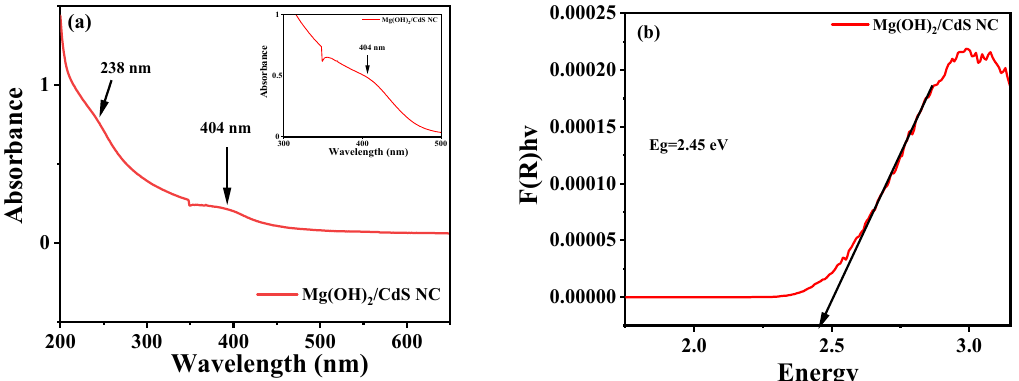
Fig. 5. (a) Showing Absorption maxima and (b) Bandgap using K-M plot of Mg(OH)